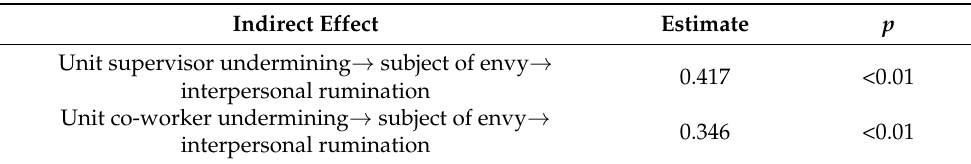
Table 6. Indirect